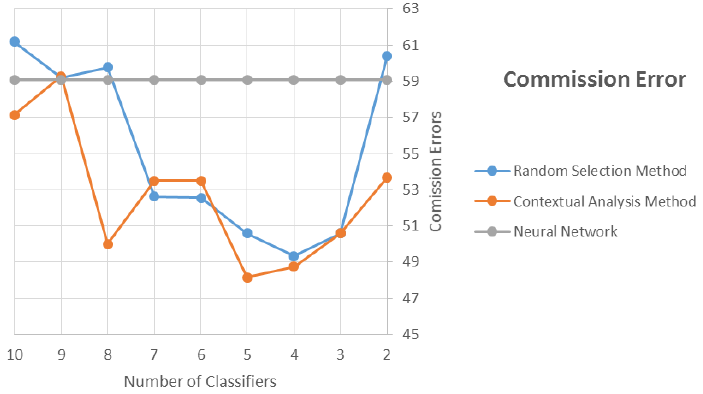
Figure 7. Evolution of the commission errors for the classifier ensembles.